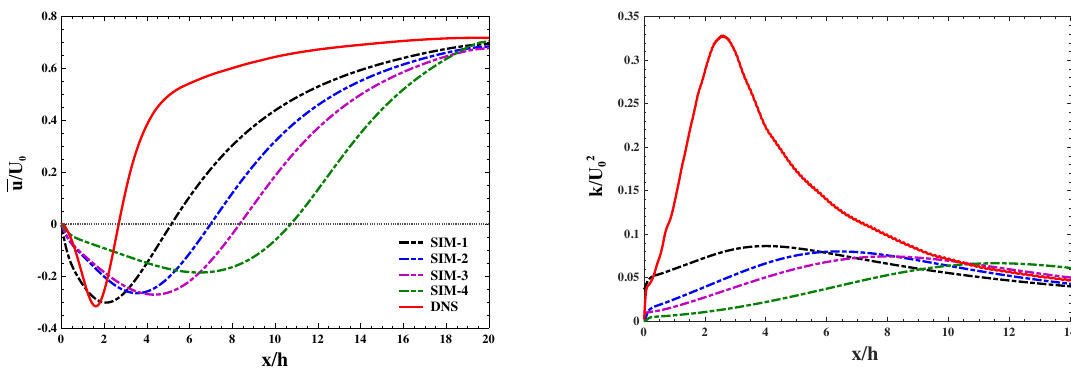
Figure 5. Comparison of the mean velocity and turbulent kinetic energy along the wake centerline compared to Reference